Question: Describe this figure in one sentence.
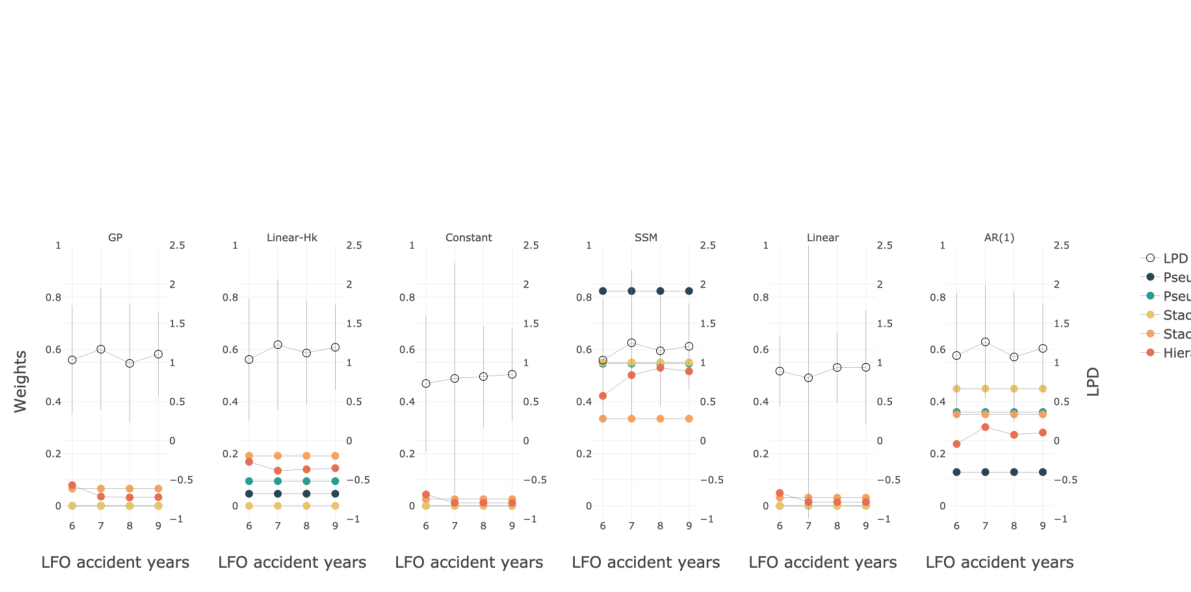
Answer: Model weights and log posterior predictive density (LPD) values from the fore- casting model. Model weights are constant across leave-future-out (LFO) accident years for every model except the hierarchical stacking model, which included accident year as a dis- crete covariate. The left y-axis illustrates the weight values for each of the blending models. The right y-axis denotes the mean (open circles) and 1 standard deviation across programs (vertical line segments) LPD values.